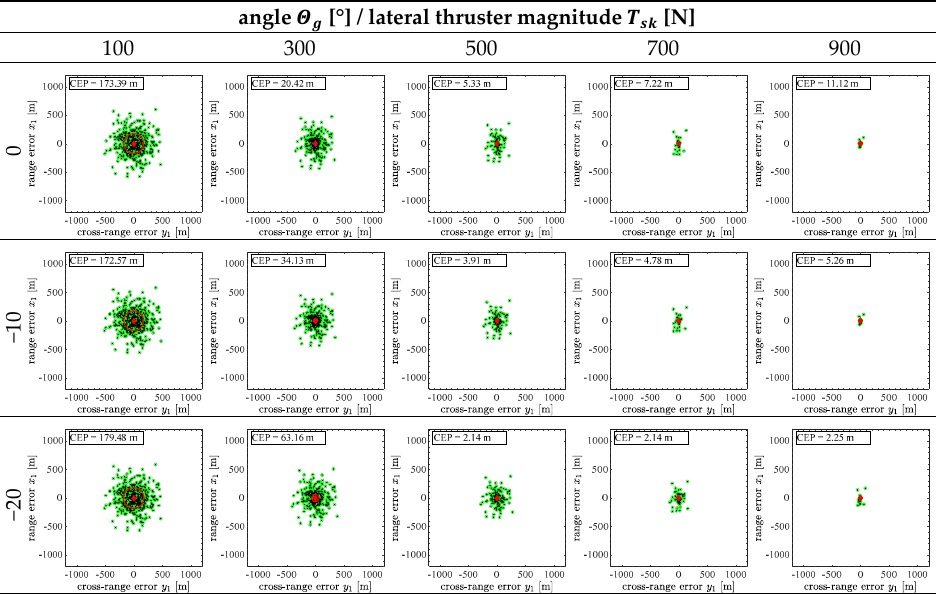
Figure 16. Dispersion patterns (nominal launch angle Θ 0 = 20 ◦ ). Figure 16 . Dispersion patterns (nominal launch angle 𝛩 (cid:2868) = 20°)